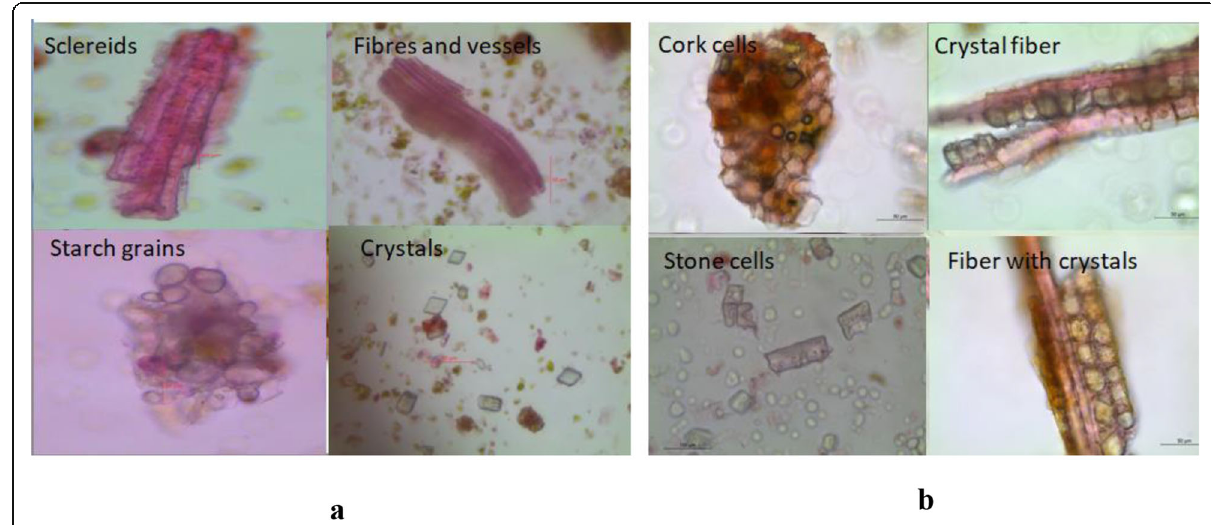
Fig. 7 Powder analysis of S . palghatense leaves ( a ) and bark ( b )